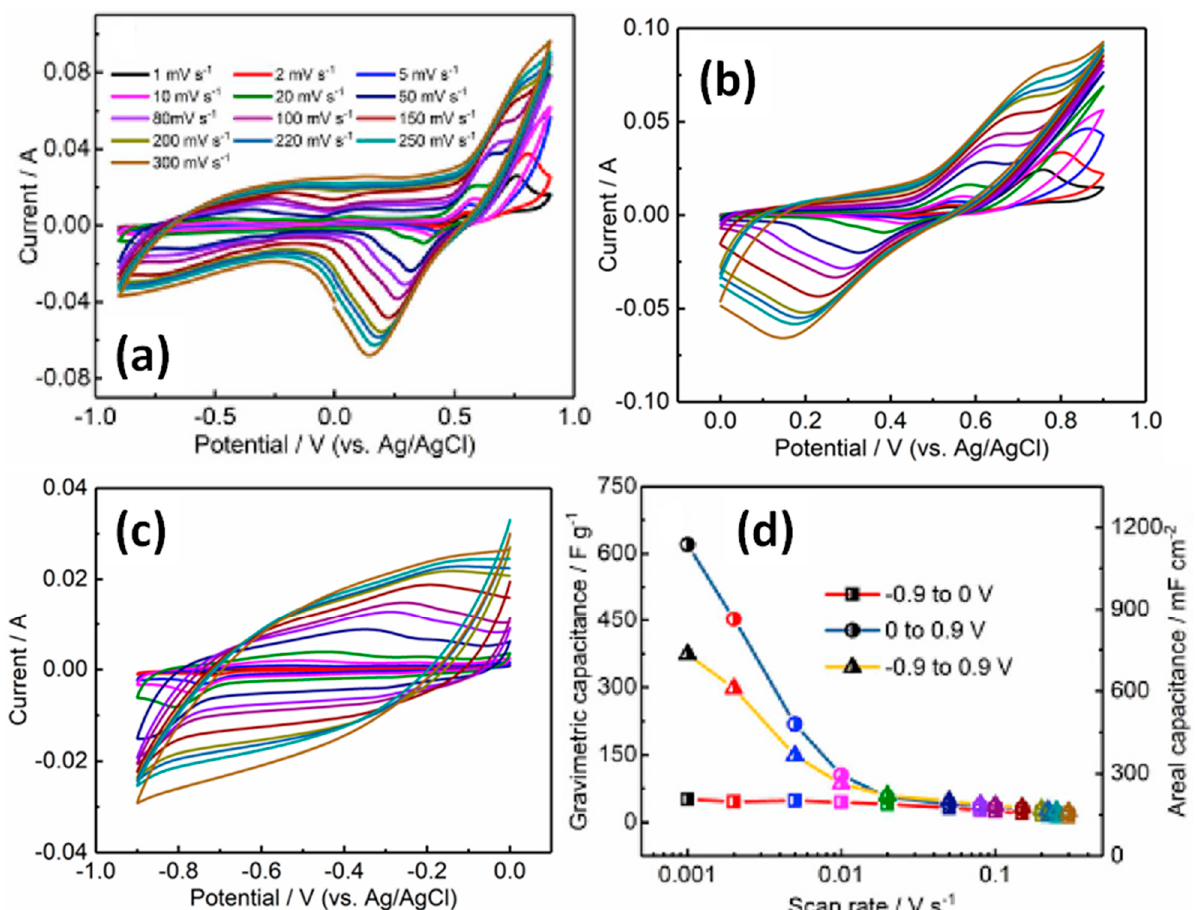
Figure 21. CV curves obtained at different scanning rates for CNT@G with mass loading of 3 mg/cm 2 measured in potential window from − 0.9 V to +0.9 V ( a ), from 0 to +0.9 V ( b ), from 0 to − 0.9 V ( c ), and corresponding specific capacitances ( d ) (Reproduced with permission of [46]. Copyright Elsevier, 2019).